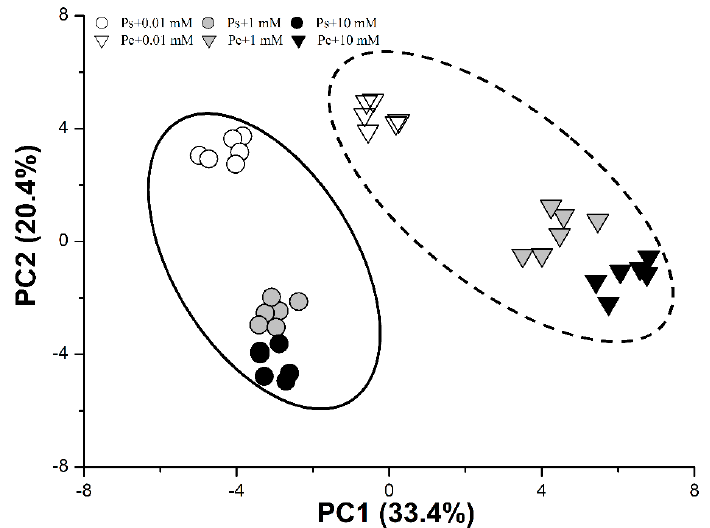
Figure 8. Principal component analysis (PCA) plot of the first two principal components in P. simonii (Ps) and Populus euramericana (Pe) under 0.01, 1, and 10 mM NH 4 NO 3 . The analysis was conducted using data of physiological parameters of Ps (circle) and Pe